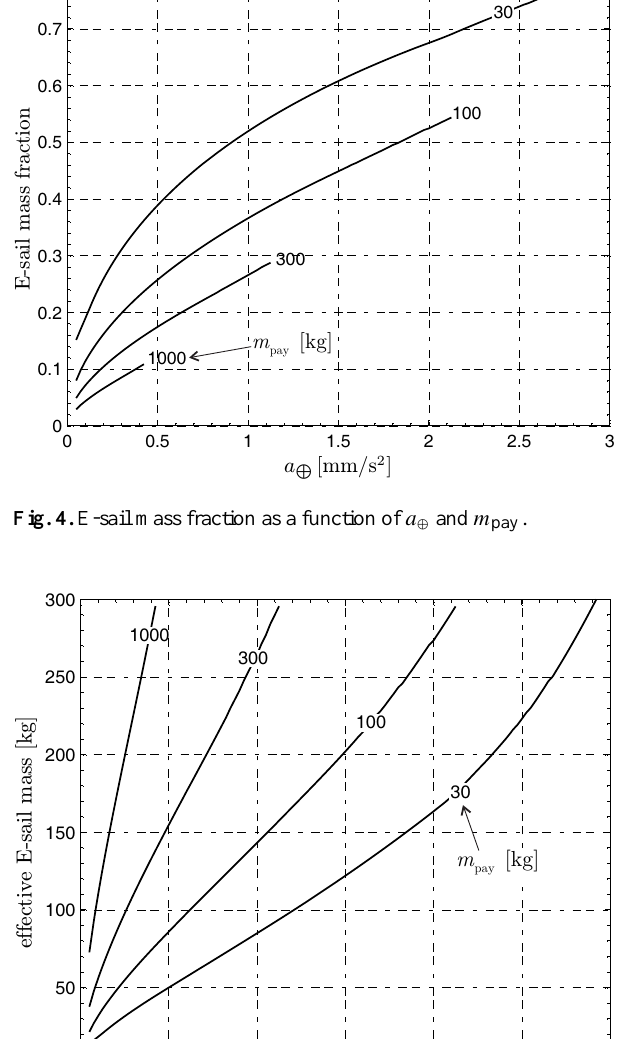
Table 5. Same as Table 4, but with thinner auxiliary tethers (7.6µm) and RUs with cold gas thrusters.